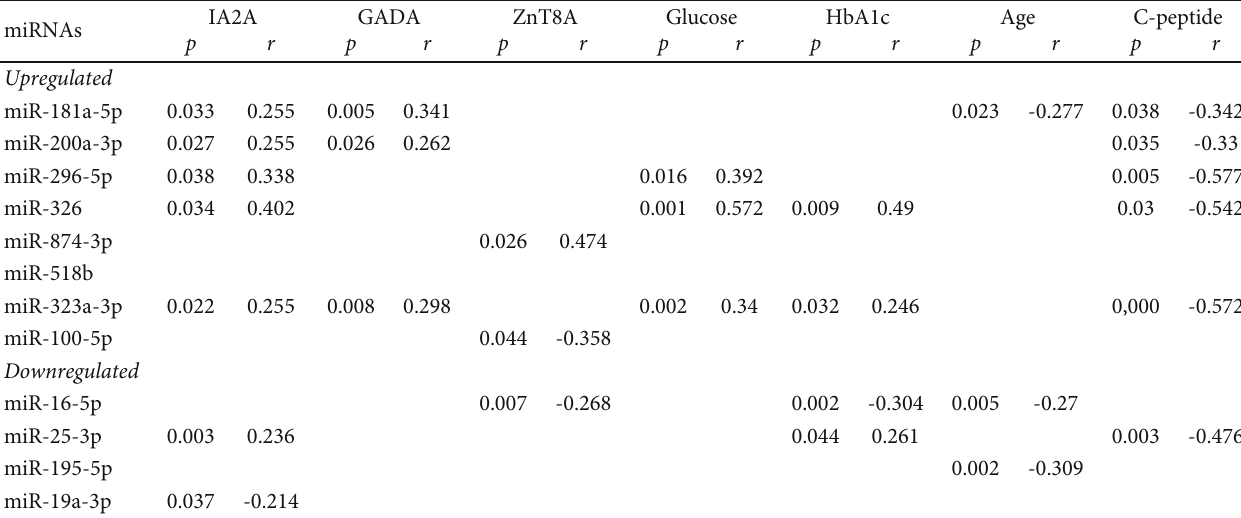
Table 4: Correlations of miRNAs from cluster